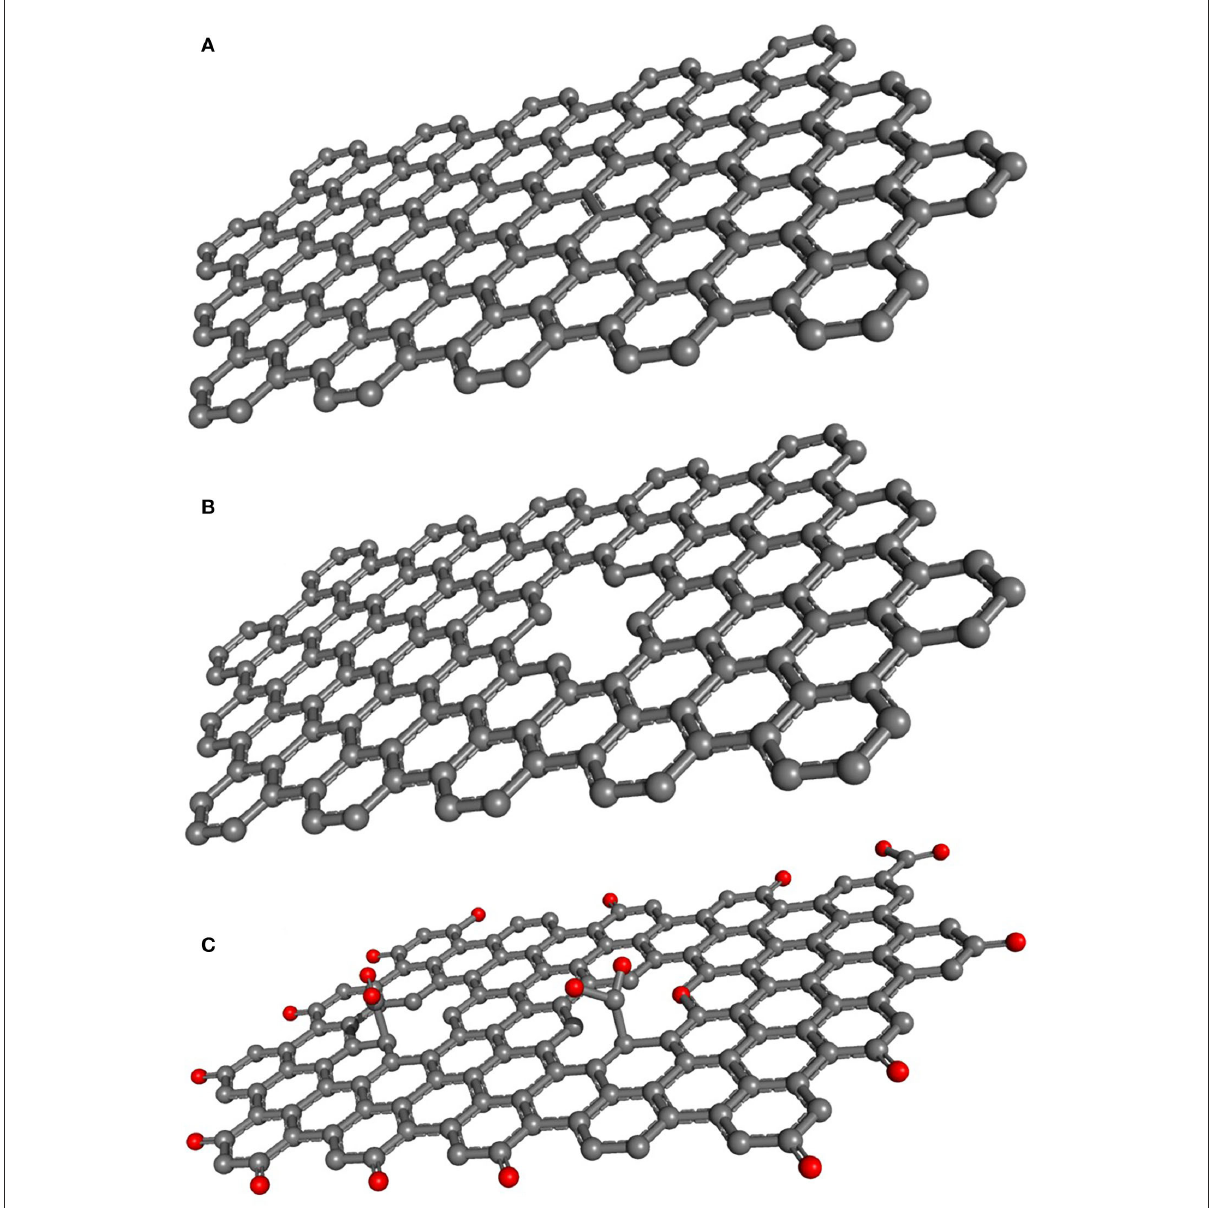
FIGURE1 (A) Pristine graphene, (B) graphene with intrinsic defects, and (C) graphene with extrinsic defects.